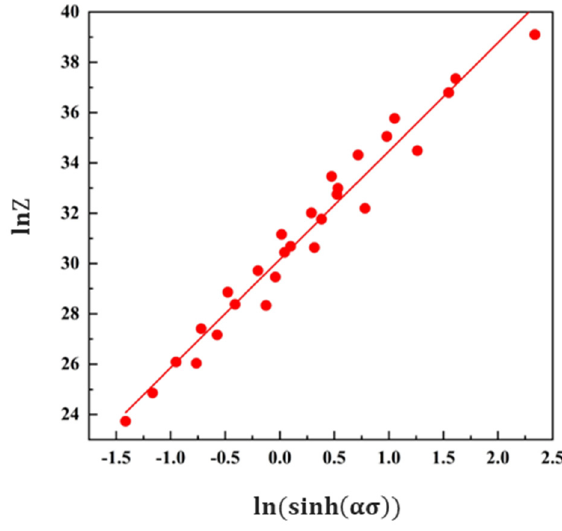
Figure 6. The fi tt ing line of the Arrhenius constitutive equation. Figure 6. The fitting line of the Arrhenius constitutive